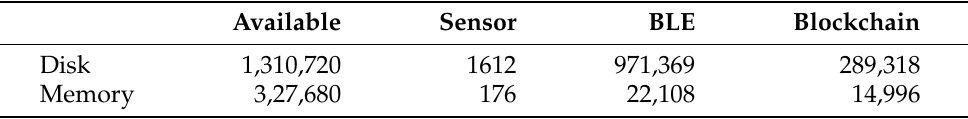
Table 4. Footprint for the device module (expressed in bytes).